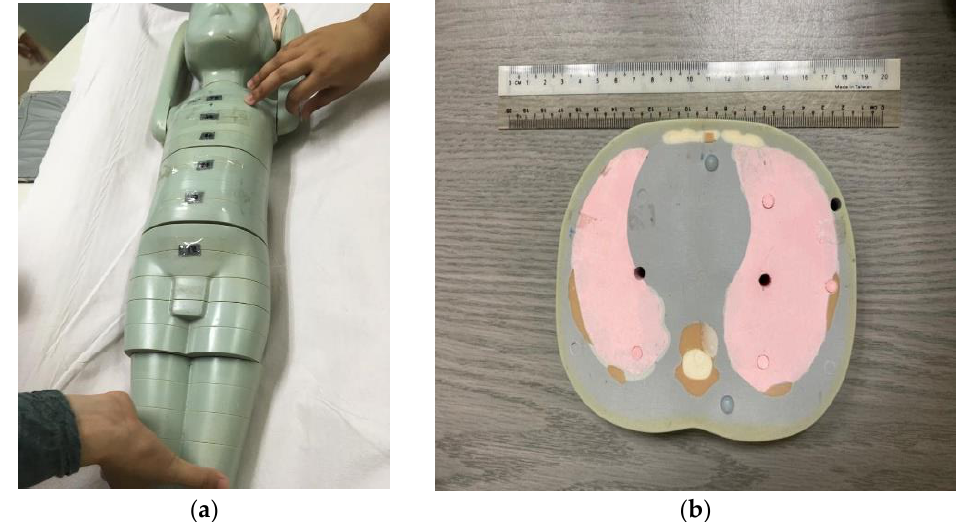
( a ) ( b ) Figure 1. ( a ) One-year-old anthropomorphic phantom was set up before the scan. ( b ) The anthropomorphic lung tissue slab comprises a-holes matrix about 5.0 mm in diameter for dosimeter insertion, such as TLD. The CT CAP examination was performed on 64 slices using a multidetector CT scan- ner (MDCT) Siemens Definition AS (Siemens Sector Healthcare, Forchheim, Germany) by applying nine different CT protocols (P1 to P9). The tube potential of P1, P2, and P3 were fixed at 100 kVp and P4, P5, and P6 were fixed at 80 kVp with various tube current reference values (ref. mAs: 210, 180, and 150), while in P7, P8, and P9 the modification was made on P1 with changes on slice collimation, pitch factor, and tube current modulation (TCM), respectively. The details of the CT acquisition parameter used in this study were shown in Table 1. The scan range starts from 1 cm above the apex of lungs and ends at 1 cm below symphysis pubis with a total length of 32 cm for all protocols involved. The source to detector (SDD) and source to object distance (SOD) used in this study were 100 cm and 50 cm, respectively. Table 1. Routine and modified CT CAP acquisition parameters used in this study. Parameter